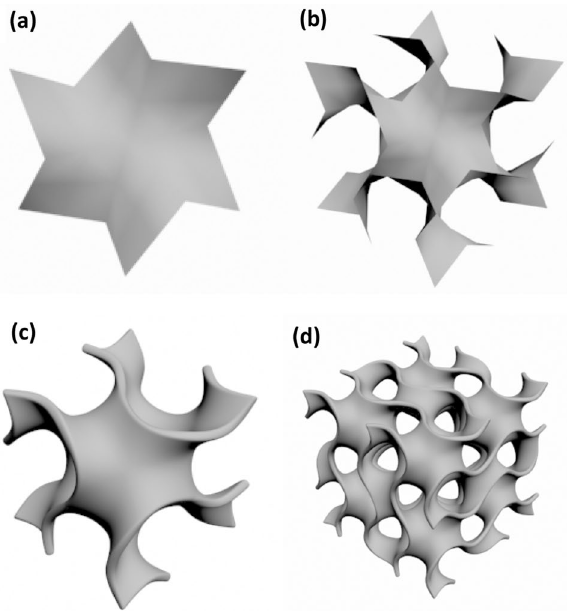
Figure 8. The model of compression sample: ( a ) hexagonal surface; ( b ) hexagonal surface was mirrored, copied, rotated and spliced; ( c ) surface of the unit surface piece was smoothed; ( d ) the element body was arrayed to obtain Gyroid minimal surface element body.